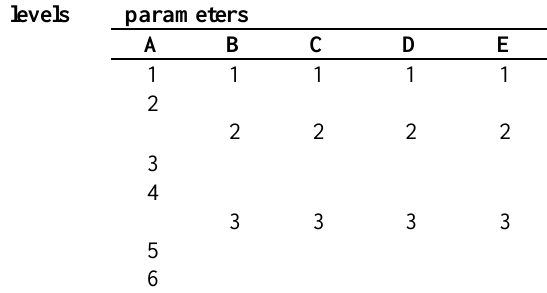
The parameters and their levels levels parameters